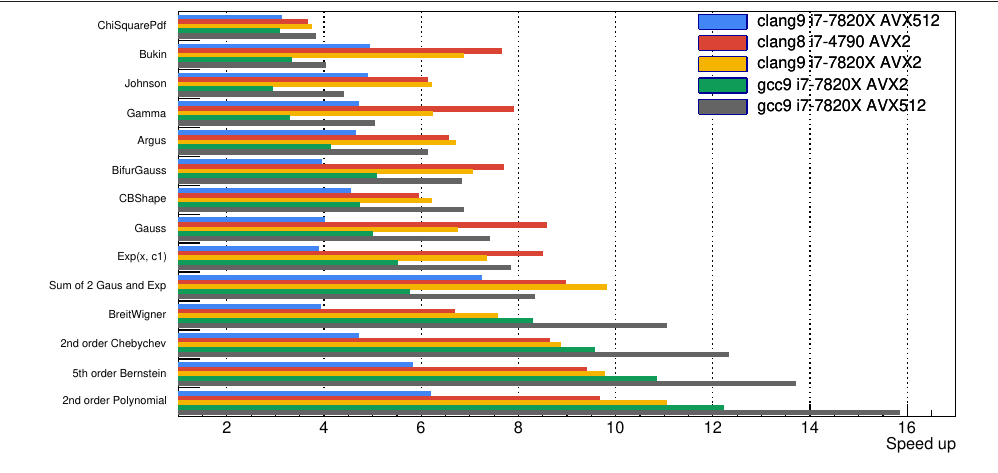
Figure 2. Speed up for computing the likelihoods of datasets of 100000 to 300000 events for various likelihood models. Using ROOT 6.20, the fast RooFit batch interface is timed against the normal single- value computations for di ff erent CPUs, compilers and instruction sets. On an intermediate-level CPU that supports AVX2 instructions ( ), a speed up of 4x to 9x can be expected. On CPUs supporting AVX512 instruction sets, the speed up ranges from 4x to 16x. For the “ChiSquarePdf” (top), almost no SIMD functions were available. The speed up of 3x is the result of batched computations with faster data